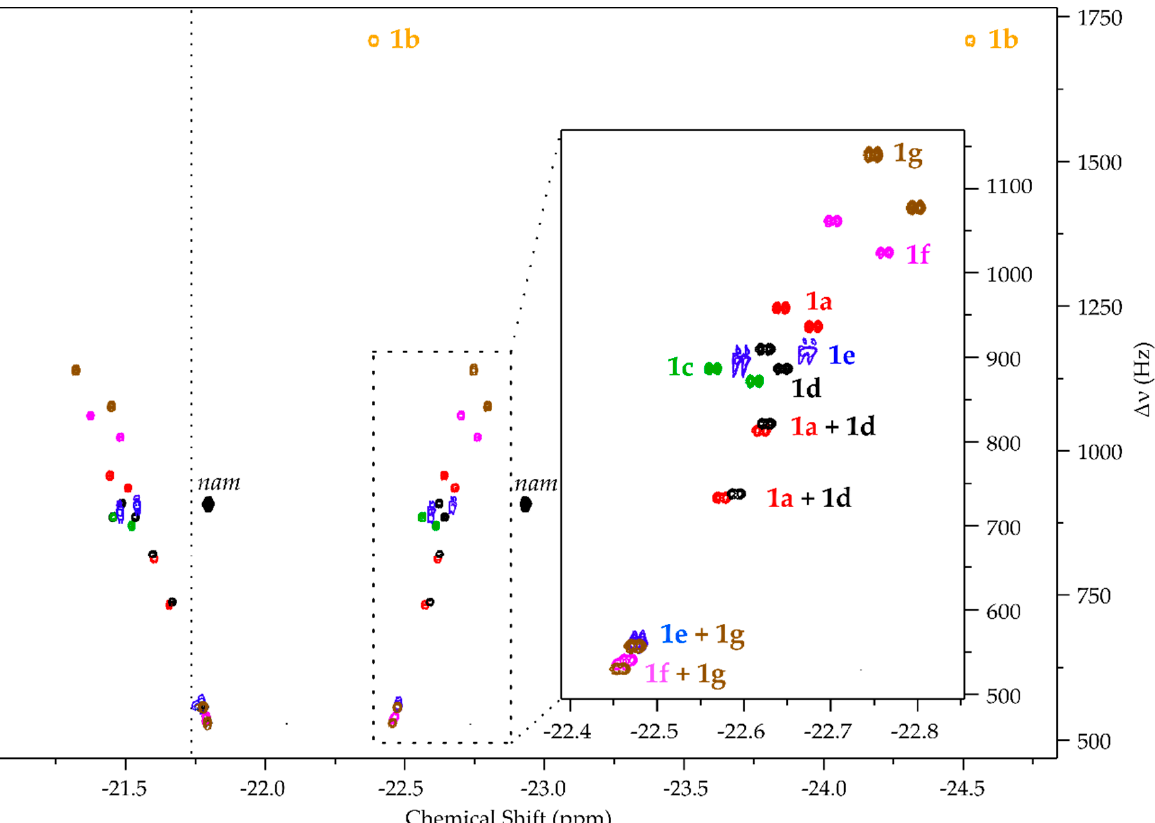
Figure 2. Hyperpolarized 2D ZQ spectra [6] of the adenosines’ library. Spectra of all compounds have been recorded separately, referenced to nam signal (using − 22.935 ppm for right hand hydride signal [6]) and superimposed. For clarity, all hydride signals for a certain compound are presented in the same color, although the doublet pairs are detected in opposite phase. All analytes ( 1a – 1g ) present at least two clearly resolved signal pairs. The dominating signal of complex 2 (dotted line at − 21.74 ppm, see Figure S1 Supplementary Materials) was omitted from the spectra by convolution filtering. See Figure S2 for hyperpolarized hydrides’ 1D spectra of all analytes and Table S1 for chemical shifts of hydride